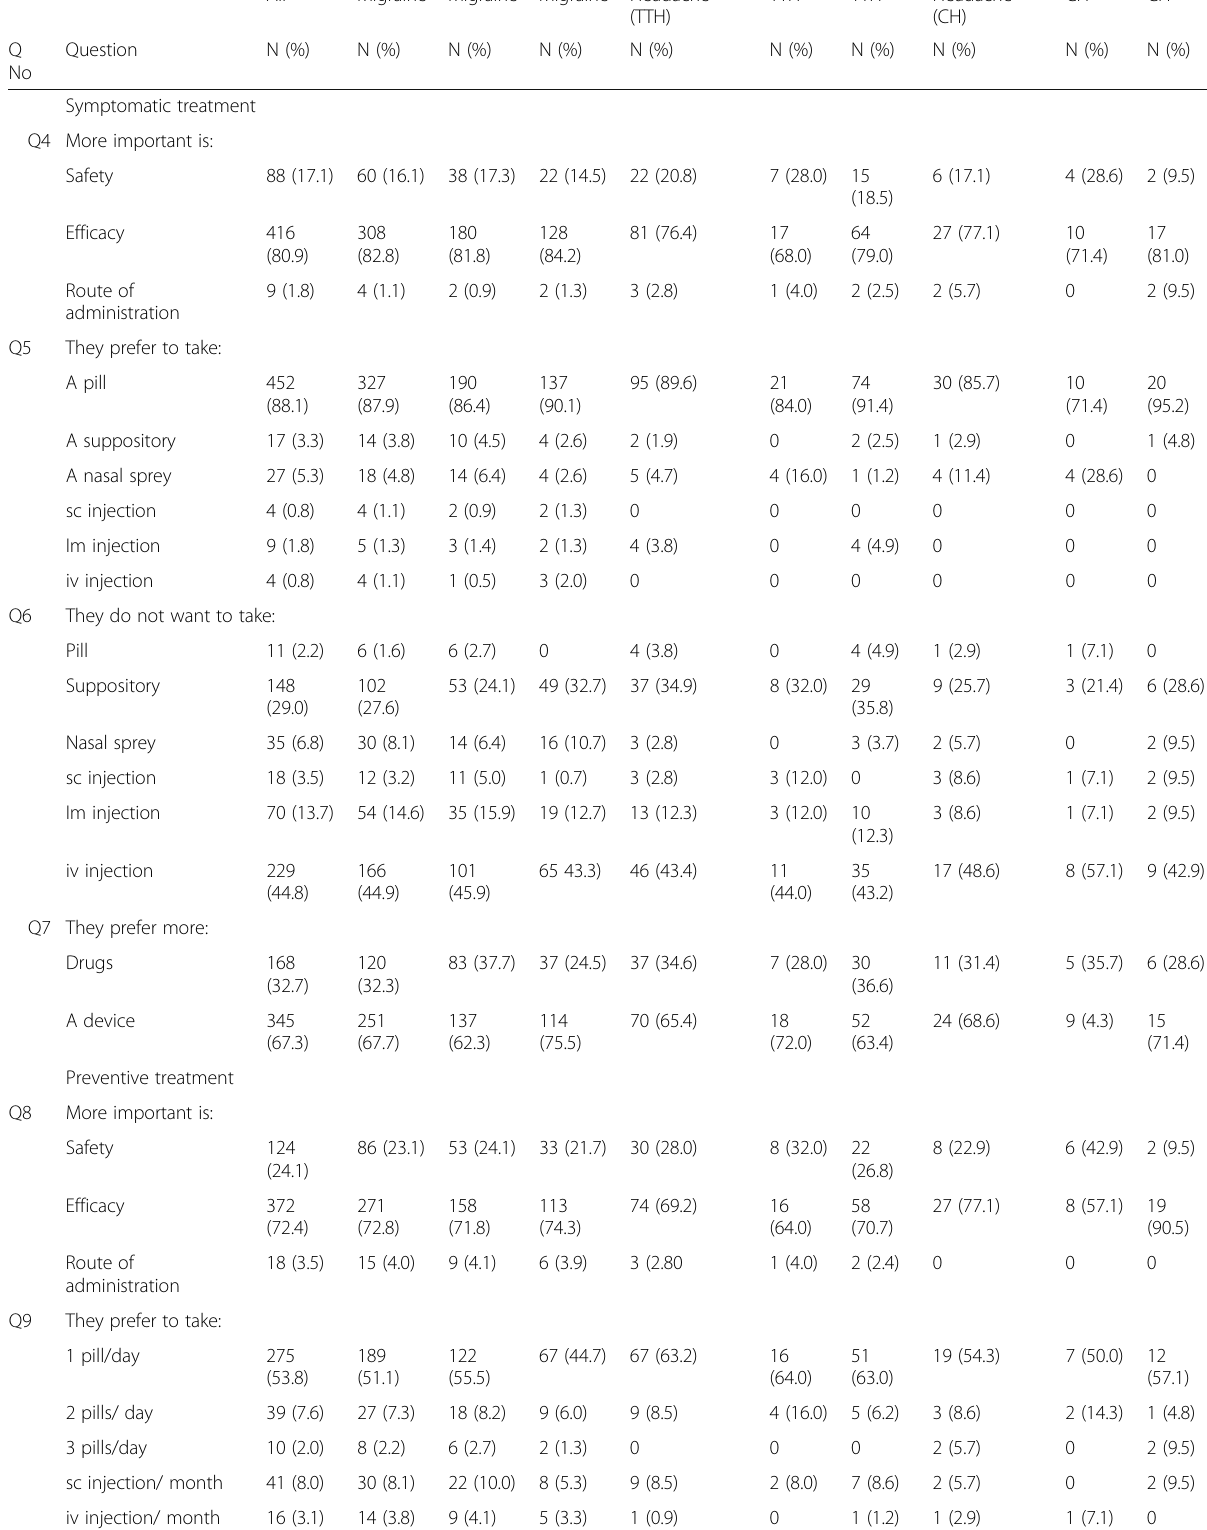
Table 2 Participants ’ preferences for headache treatment by primary headache disorder